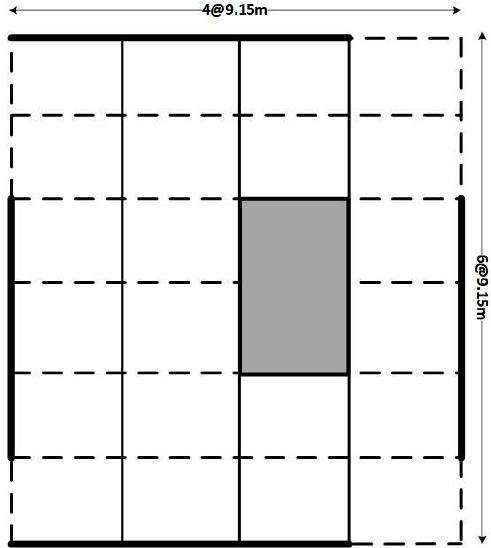
Figure 1. Top view of the structure.